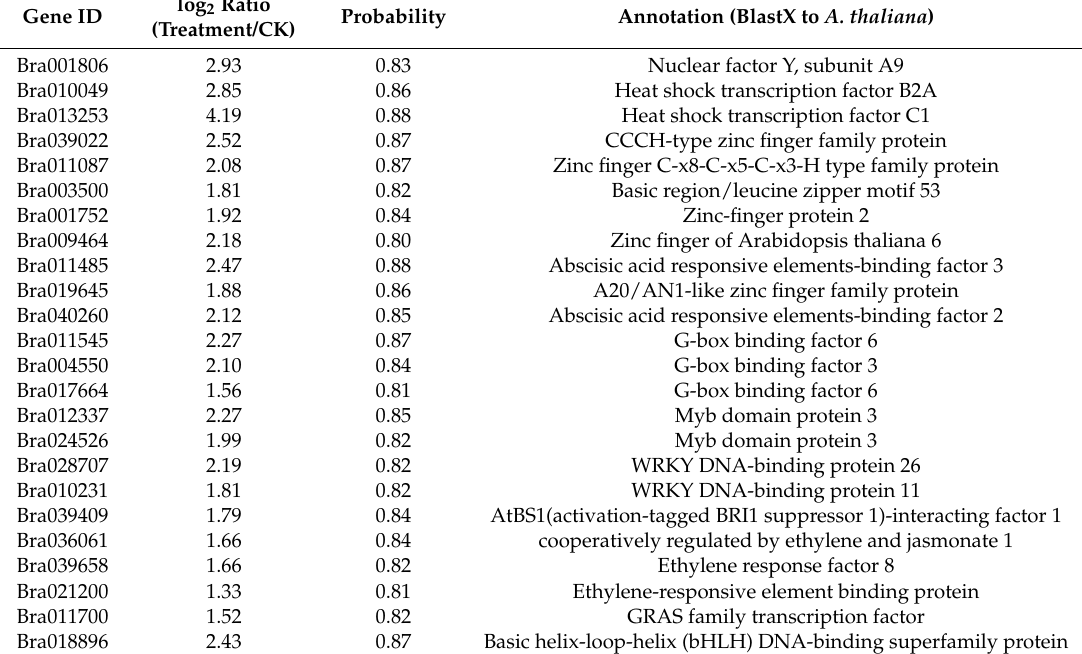
Basic helix-loop-helix (bHLH) DNA-binding superfamily protein